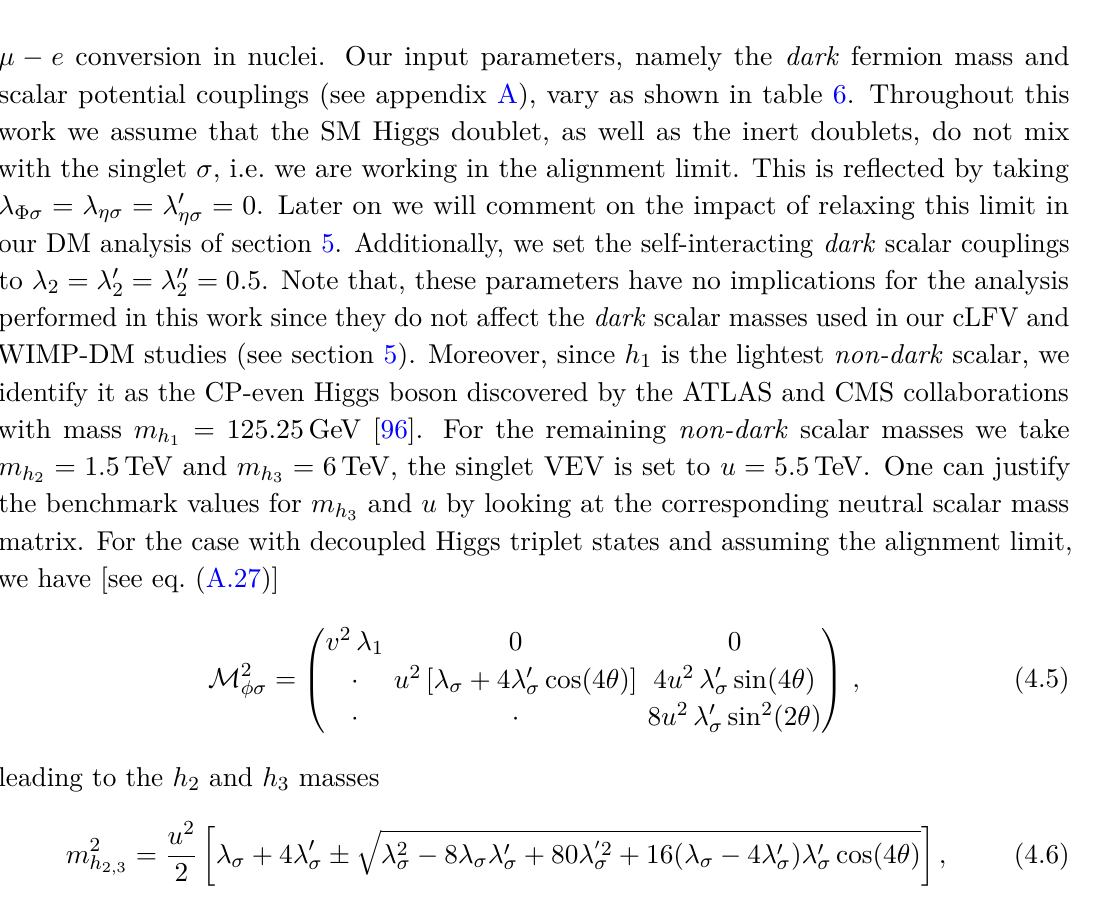
Table 6 . Input parameters of our model and corresponding ranges used in our numerical scan. Scalar couplings involving the Higgs triplet are discussed in the text. The Yukawa couplings and SCPV phase θ are reconstructed through eqs. (3.5)–(3.9) using the best-fit values for low-energy neutrino